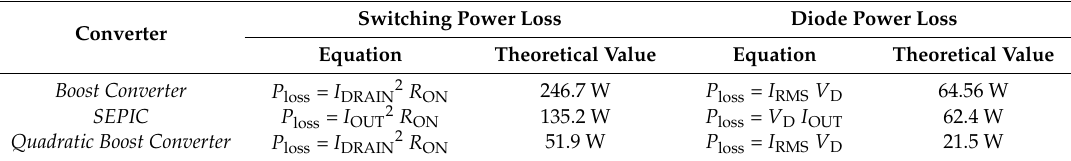
Table 5. Switch Power Loss and Diode loss associated with boost, sepic and quadratic boost converters.